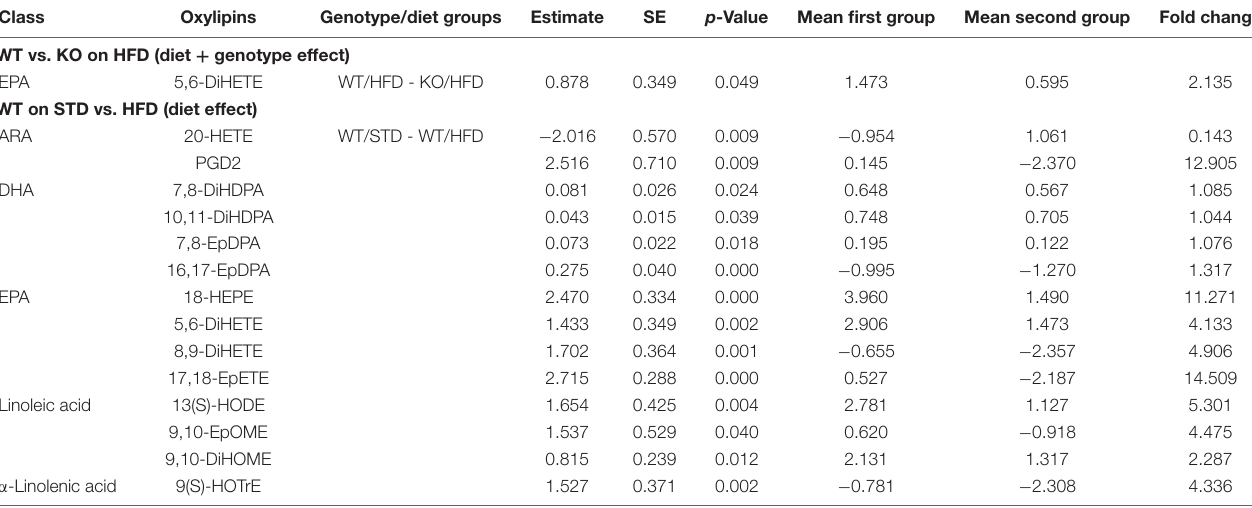
TABLE 3 | Plasma oxylipins in GPR39 KO and WT littermate mice fed with standard diet and high fat